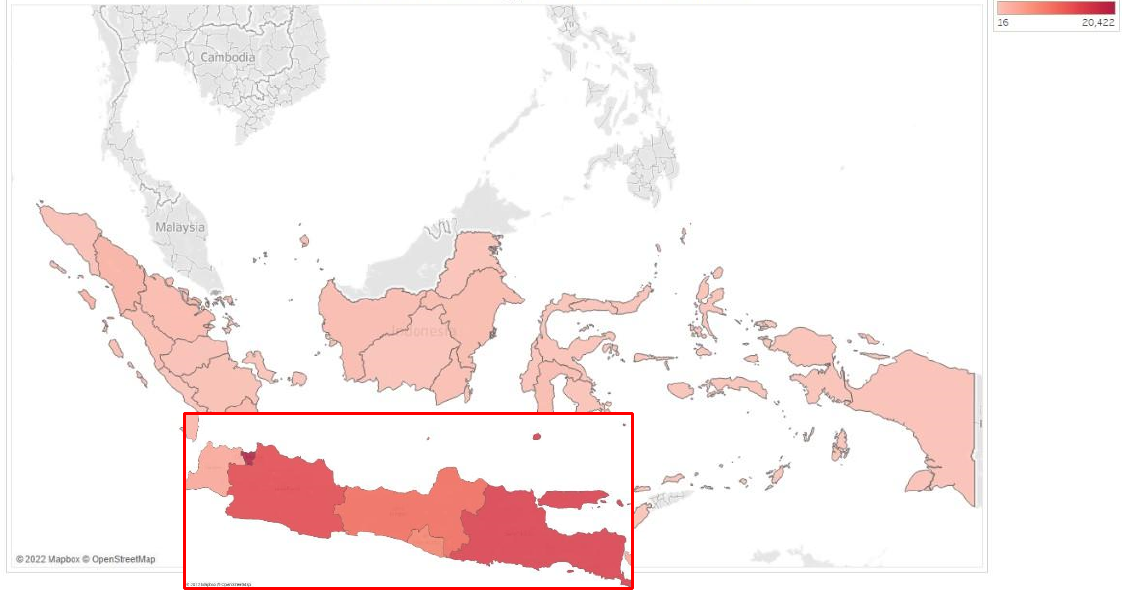
Fig. 4 Maps classification of “Indicated mental